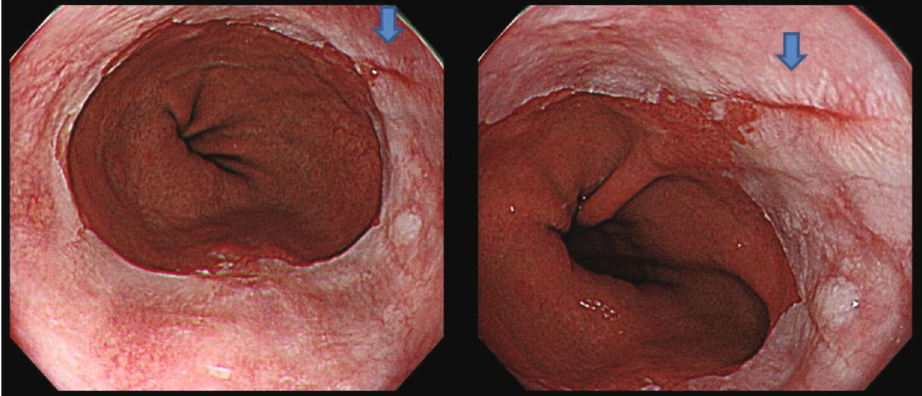
Figure 1: Example image fi le of white-light endoscopy images used in the study. All 8 endoscopists judged the areas marked with a blue arrow to be a mucosal